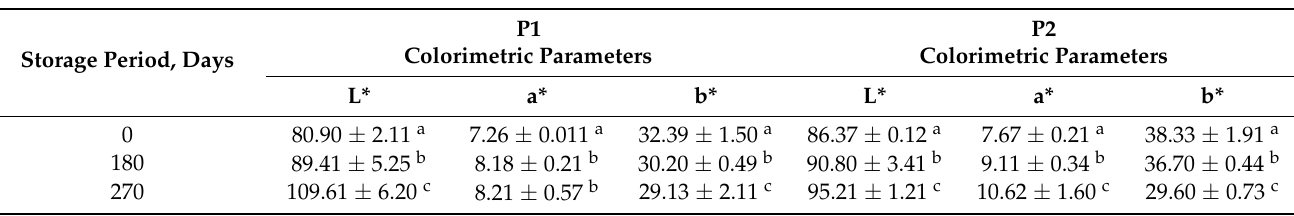
Table 5. Colorimetric parameters of the powders obtained by the microencapsulation of the sea buckthorn extracts and its stability during 270 days of